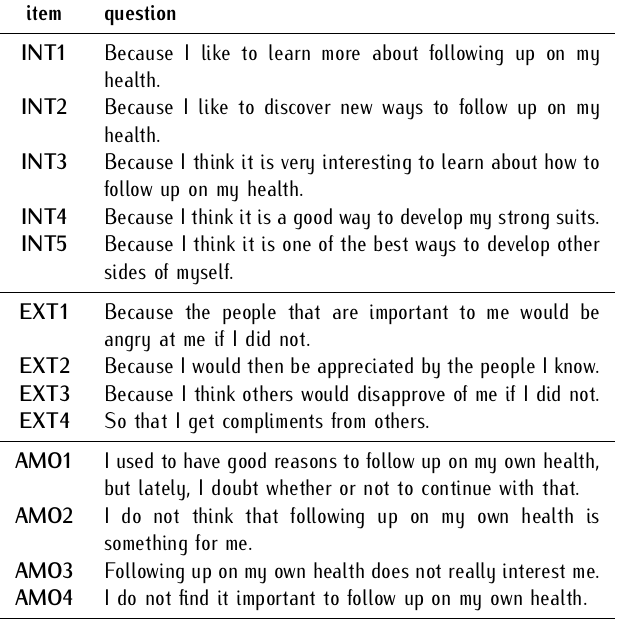
Table 1. All statements (“I would like to use a self-management health system, because...”) from the motivation scale for health monitoring, divided over intrinsic (INT), extrinsic (EXT), or amotivation (AMO). Statements are based on the study from (author?) [30] and extended with two more items for amotivation (AMO3 and